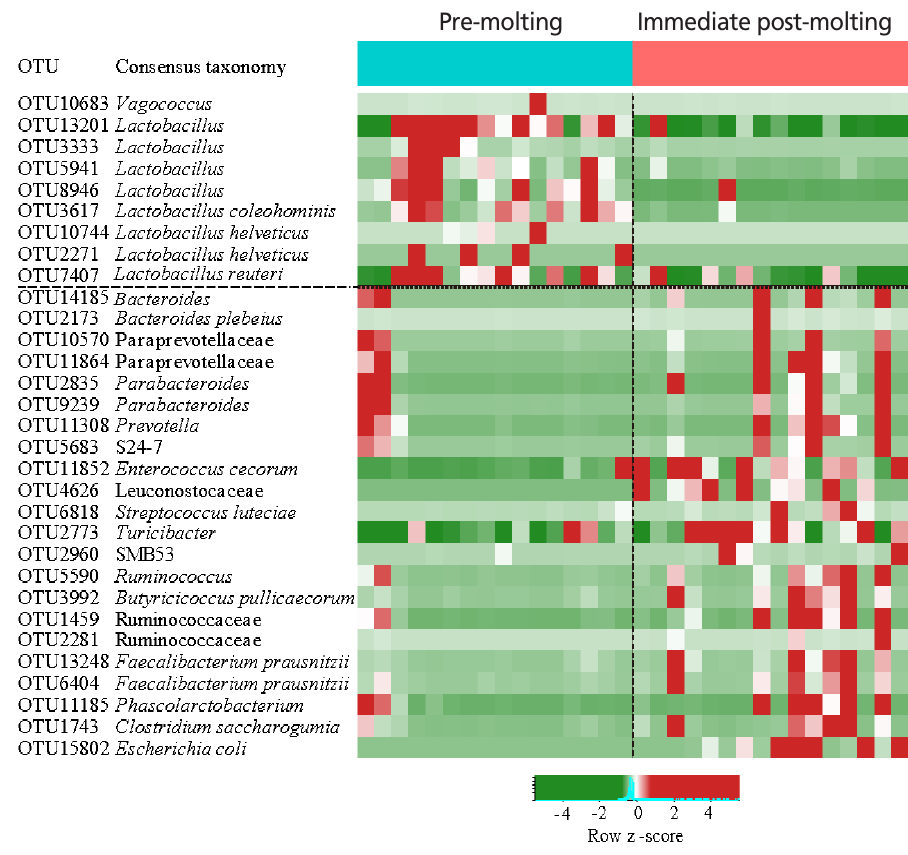
Figure 4. Heat map and logarithmic linear discriminant analysis scores of the differentially abundant bacteria between pre-molting and immediate-post molting hens determined by LEfSe analysis ( α <0.05, Kruskal-Wallis test). LEfSe, linear discriminant analysis effect size.